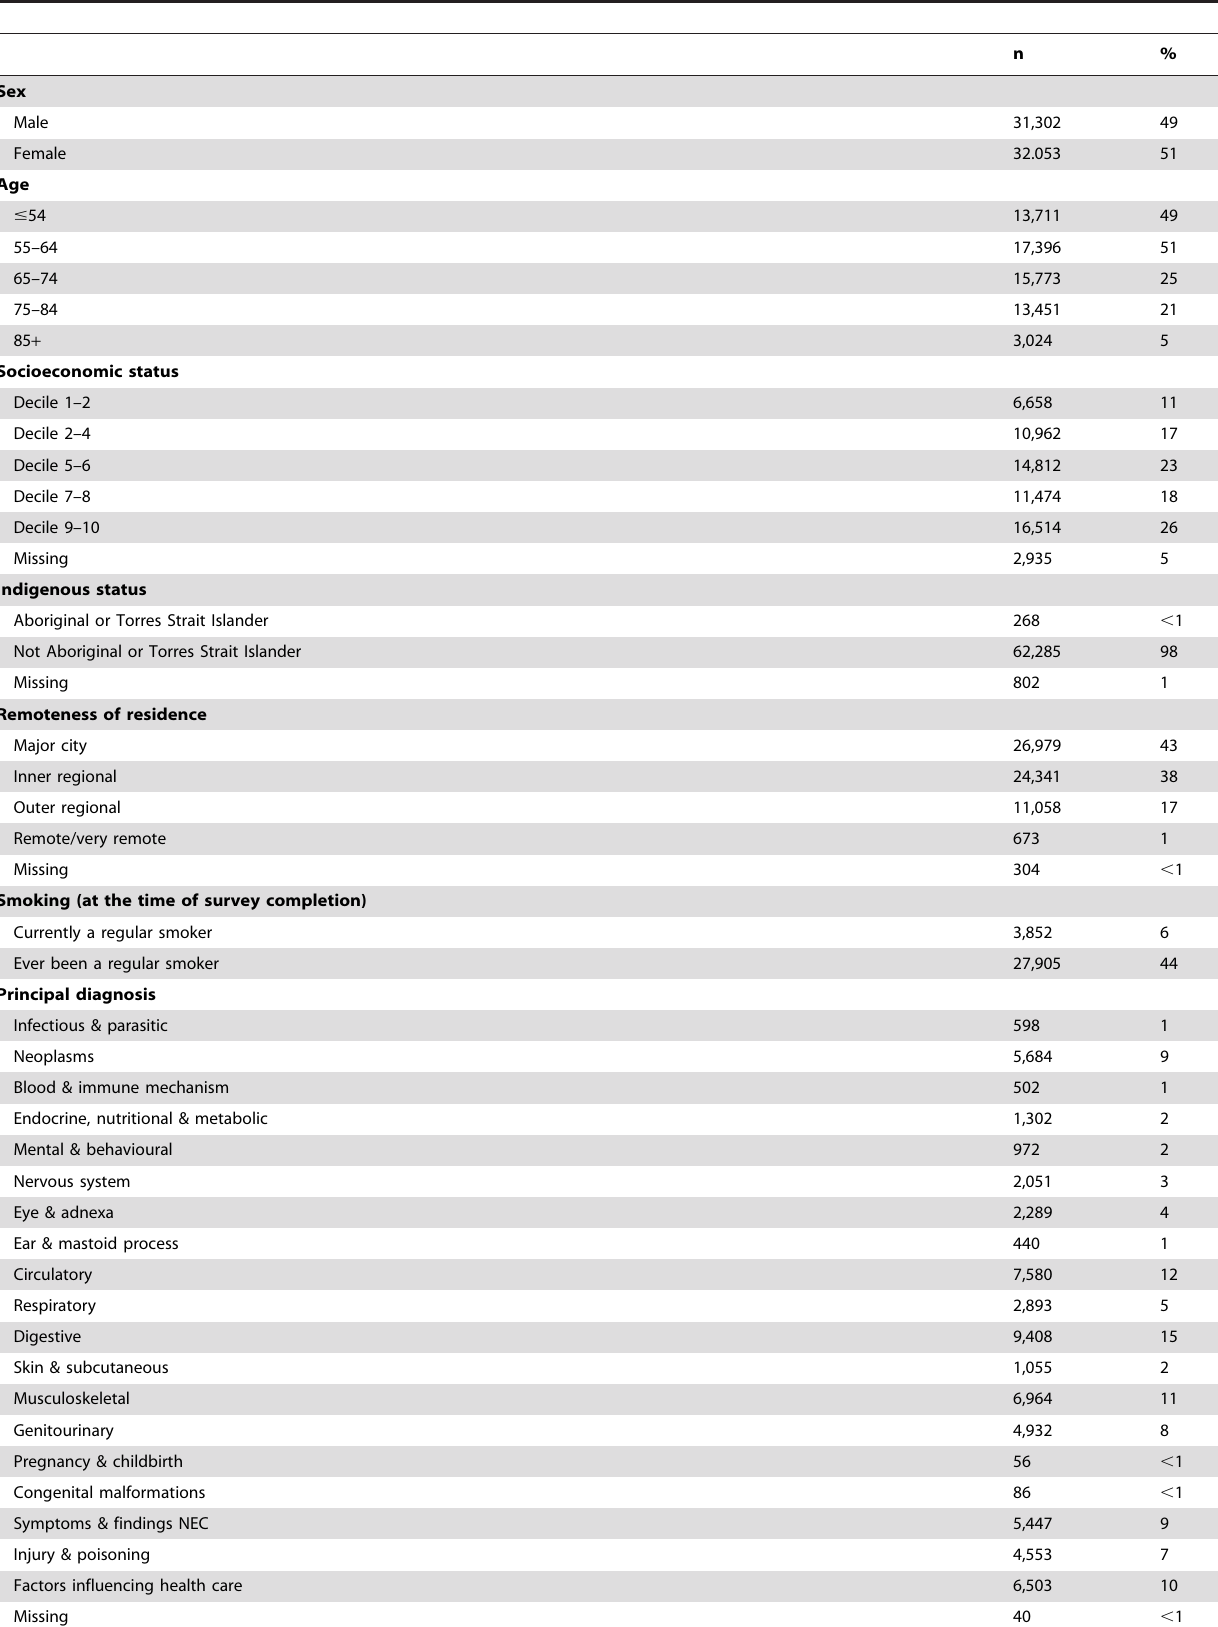
Table 3. Characteristics of participants at the time of their most recent hospital